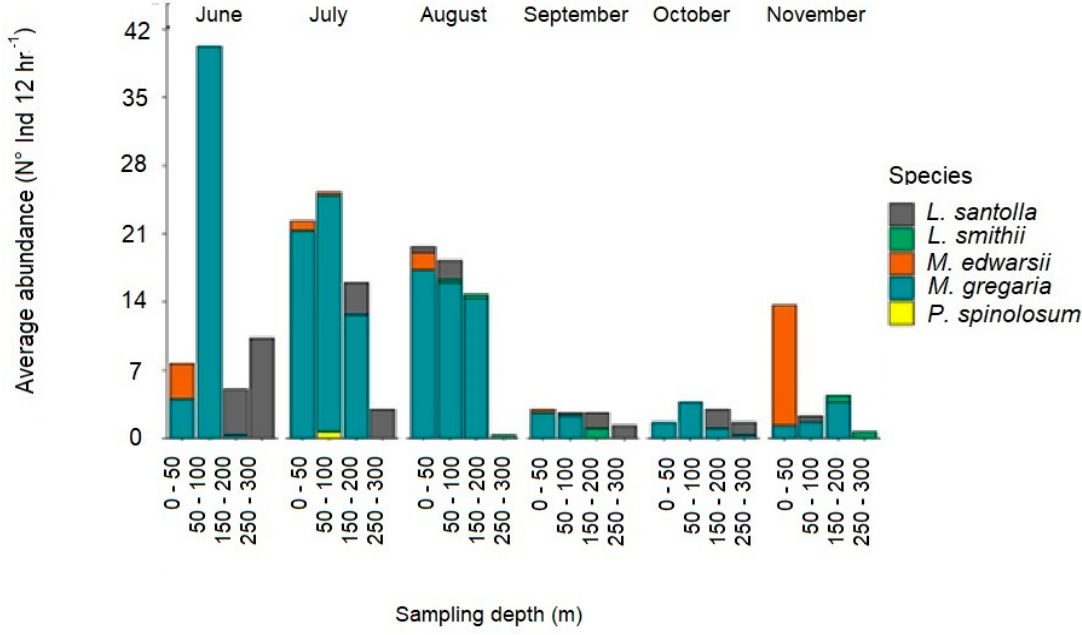
Figure 2. Monthly and bathymetric abundance of the decapods associated with the southern king crab fishery. The correlation analysis between depth and species abundances revealed a direct signifi- cant correlation between depth and L. santolla abundance, and significant inverse associations between depth and M. gregaria , M. edwardsii and total species abundance (Table 3). Table 3. Results of Kendall correlation analysis for decapod species reported and total decapod species reported and depth (“ p ” values lower than 0.05 and asterisks “*” denote significant correla- tions, n.s = non